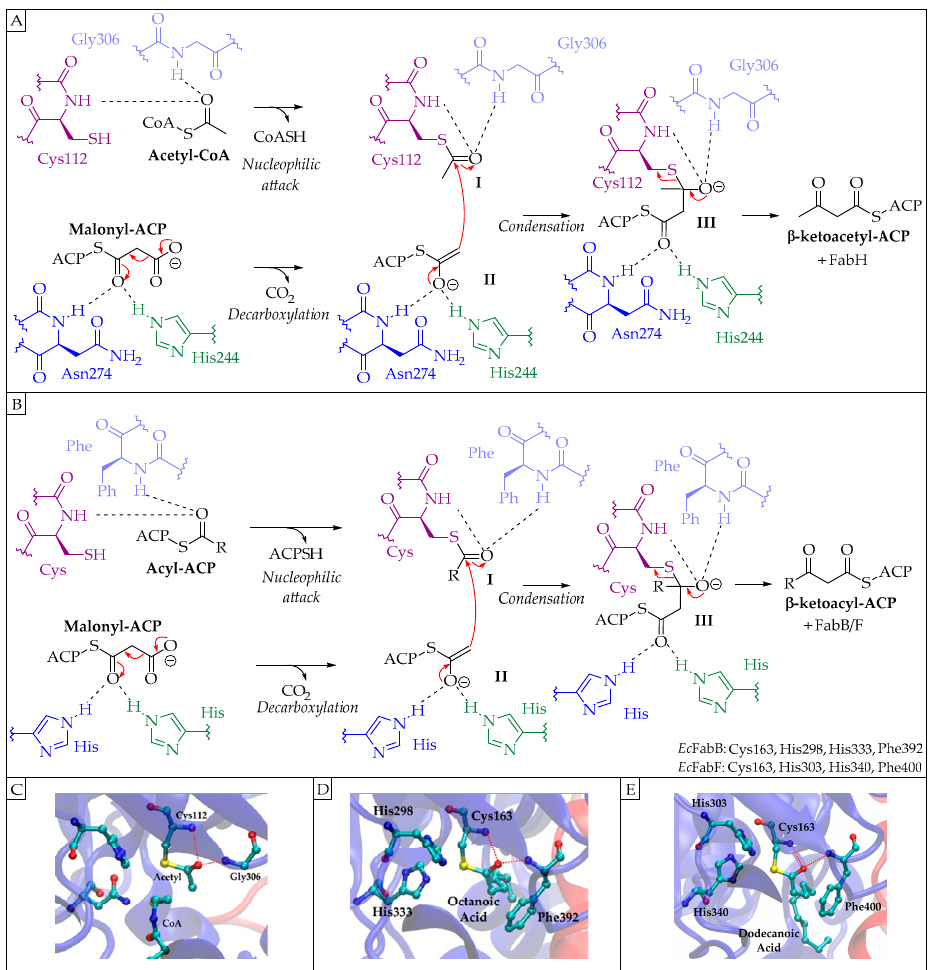
Figure 5. Scheme of the mechanism of the condensation reactions catalysed by FabH ( A ) and FabB/F ( B ) in E. coli . ( C ) View of the active site of Ec FabH-acetyl-CoA structure (PDB ID 1HNH) highlights hydrogen bonds between the carbonyl of acetyl covalently bound to Cys112 and the main-chain amides of Cys112 and Gly306 which form the oxyanion hole (red dots). ( D ) View of the active site of Ec FabB-octanoic acid structure (PDB ID 2BUI) highlights hydrogen bonds between the carbonyl of octanoic acid covalently bound to Cys112 and the main-chain amides of Cys163 and Phe392 which form the oxyanion hole (red dots). ( E ) View of the active site of Ec FabF-dodecanoic acid structure (PDB ID 2GFY) highlights hydrogen bonds between the carbonyl of dodecanoic acid covalently